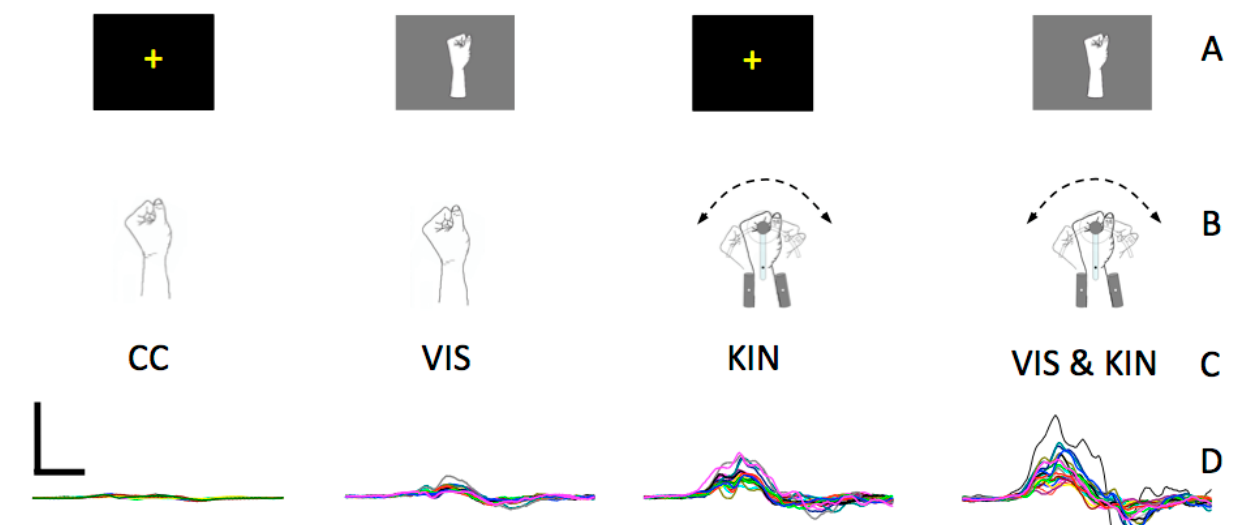
Figure 2. Representative trials of one subject illustrate the MEP of the extension directed movement. The different conditions represent the MEP response of the extensor carpi radialis at the control condition (CC), the visual wrist extension perception (VIS), the merely kinematic condition (KIN), and the coupled visual and kinematic wrist extension condition VIS & KIN (right). All MEPs have the same scale-units. Calibration bar: 0.5 mV, 10 ms. ( A ) Screen, ( B ) Manipulandum, ( C ) Condition, ( D ) MEP.